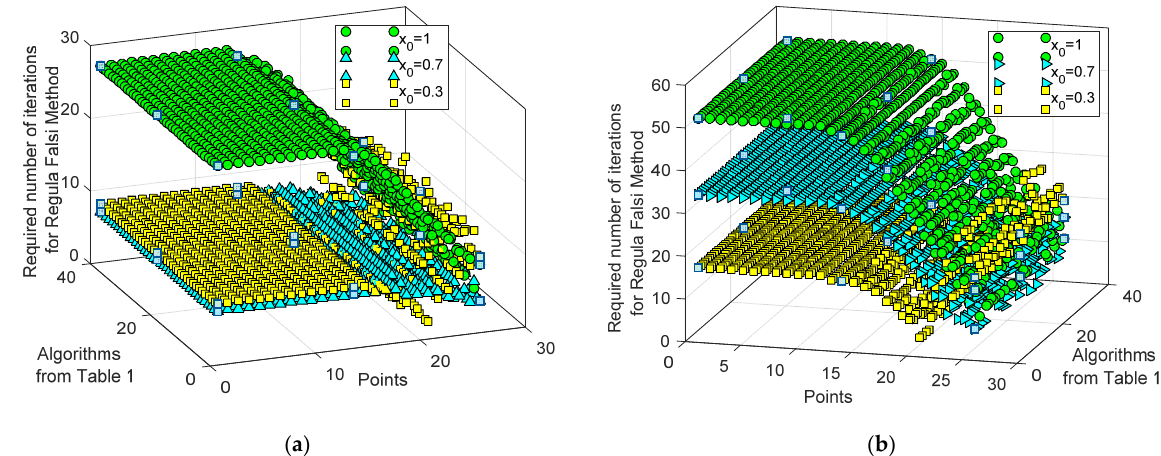
Figure 6. Required number of iterations for all voltage values with different stopping criteria using RFM: ( a ) 10 − 5 ; ( b ) 10 − 10 .